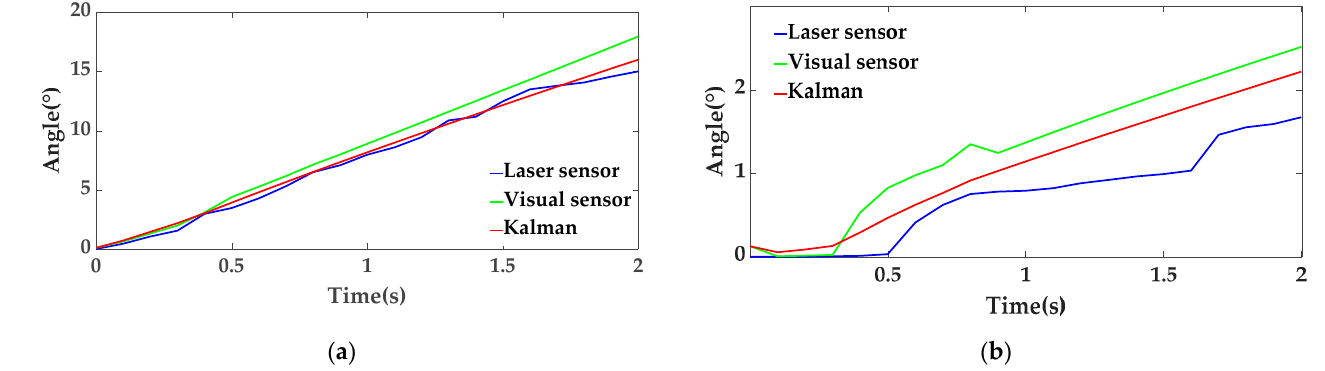
14 of 19 Figure 12. Euler angle diagram measured by vision sensor, rotated 15° around the y-axis, where ( a ) is β 1 ; ( b ) is α 1 ; ( c ) is γ 1 . It can be clearly seen from Figures 11 and 12 that when the locking mechanism jitters, the visual sensor also jitters, resulting in measurement error. The vision sensor produces an error of 2.5° when the platform actually rotates 15°. The other two attitude angles have relative errors, but γ 1 shows little change, and α 1 also produces an error of 2.5 °. At this time, the laser sensor is used for weighted filter processing, and the three laser sensors on the moving platform are used to measure relative to the lock. The distance information of the organization is shown in Figure 13 below. Figure 13. Distance of three laser sensors.